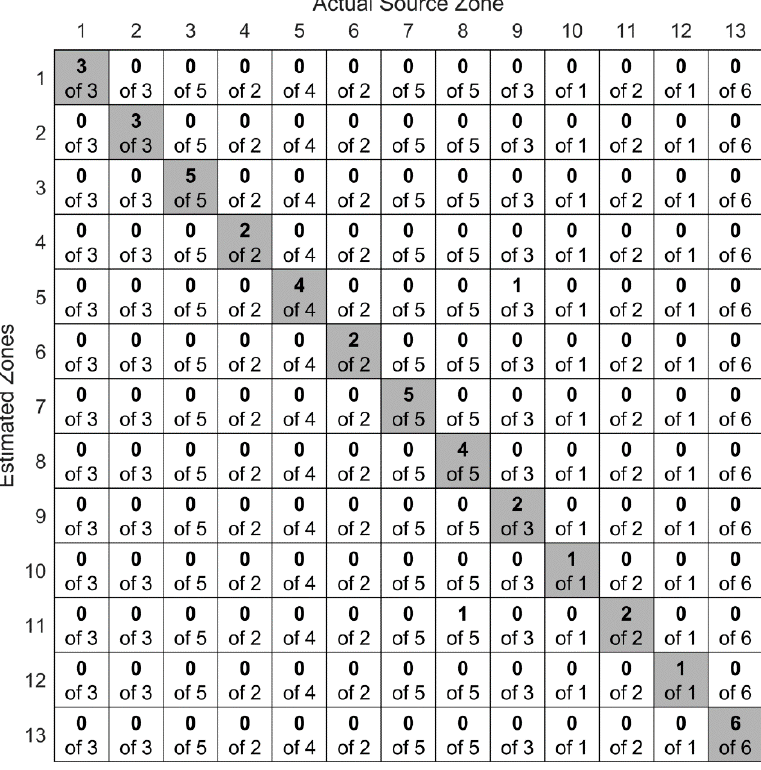
Figure 19. Confusion matrix of the convolutional neural network for the second experimental scenario.